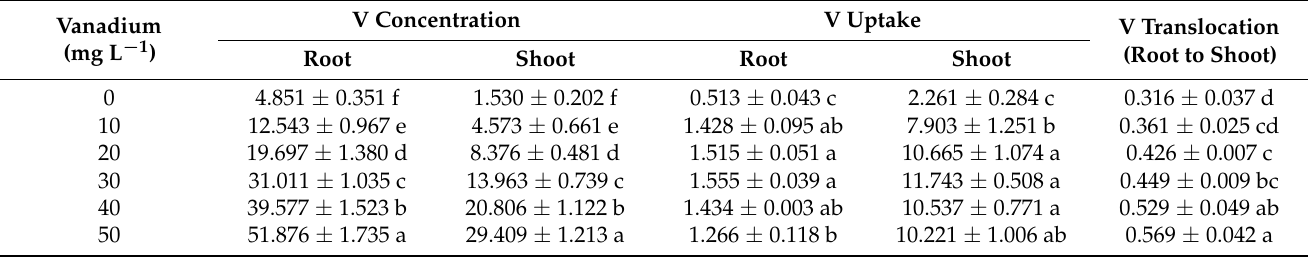
Table 2. Effects of vanadium on vanadium translocation (root to shoot), vanadium concentrations and uptake (in roots and shoot; mg kg − 1 DW) in pepper